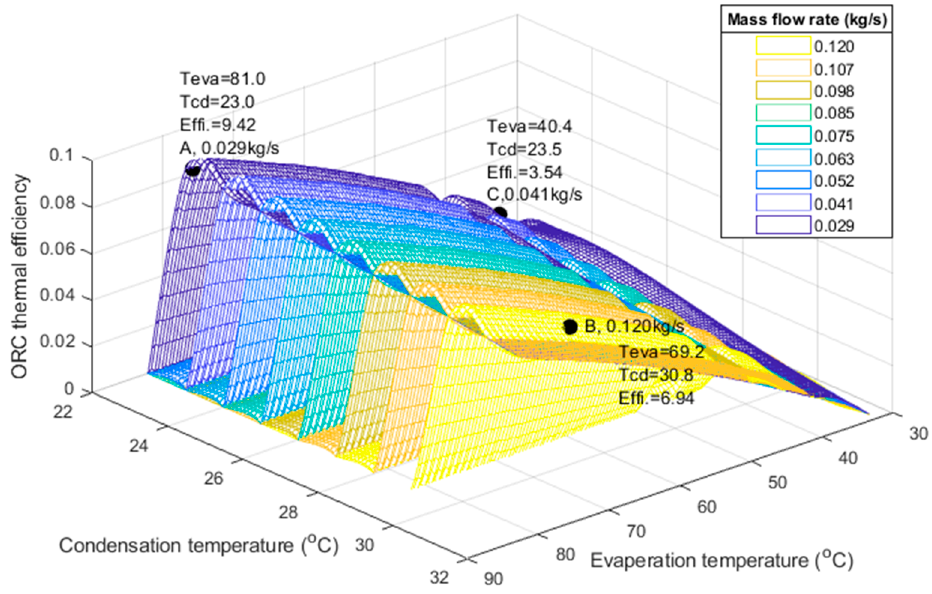
Figure 6. ORC thermal efficiency map within 4D boundary conditions.